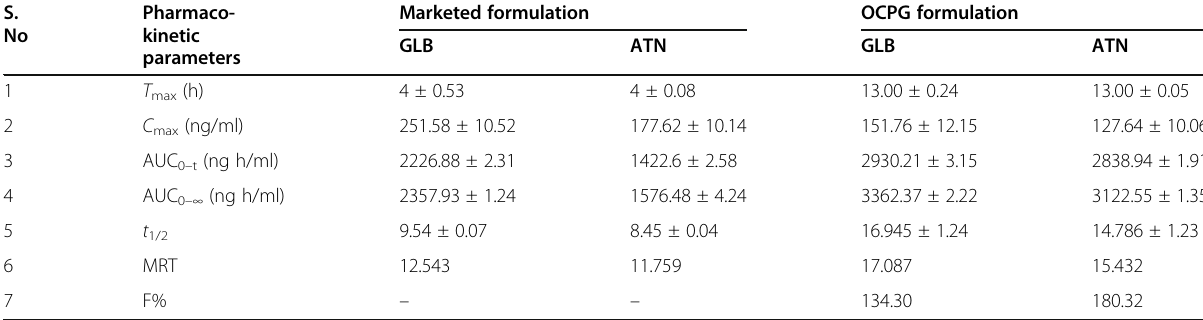
Table 7 Pharmacokinetic parameters of ATN and GLB in rabbits S. No